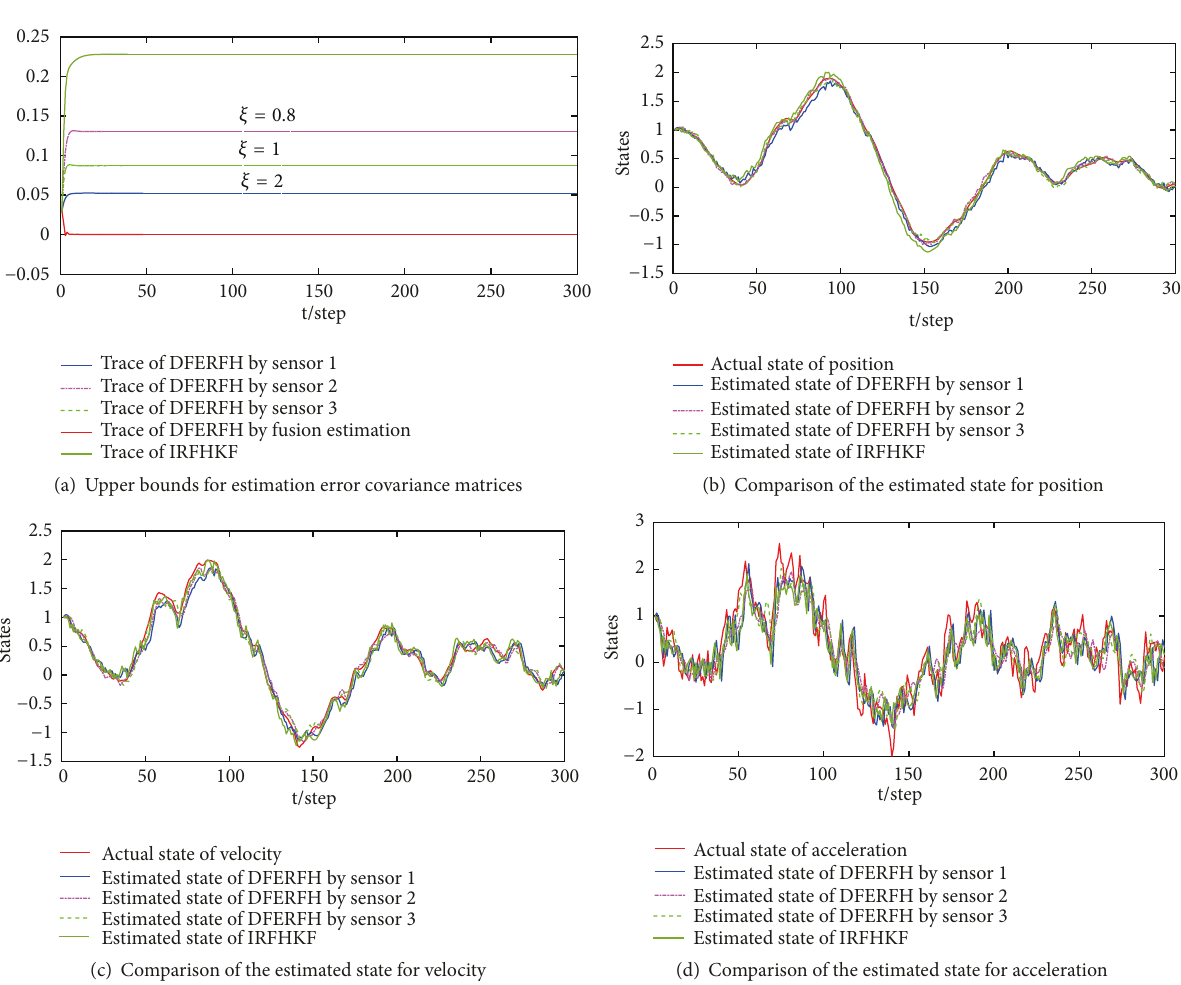
Figure 3: Comparison of proposed method and